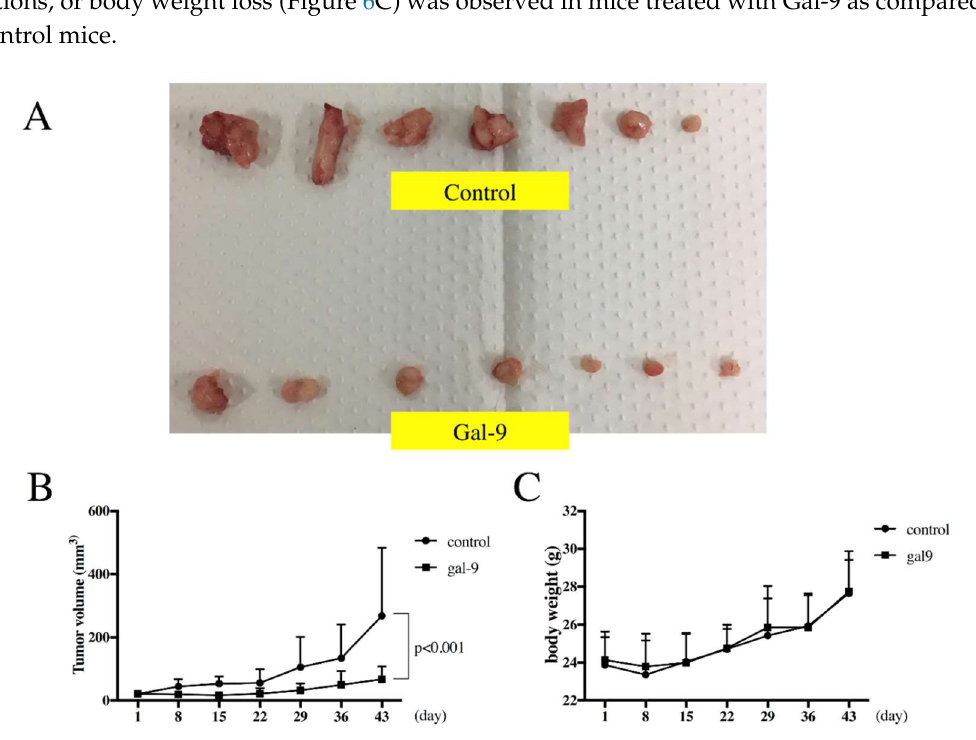
Figure 6. Gal-9 inhibits the growth of ESCC cells in the xenograft mouse model. ( A ) Image of tumors excised from Gal-9–treated and control (only PBS) mice; ( B ) Mean tumor volume of Gal-9 treated mice and control mice. KYSE-150 cells (5 × 10 6 cells / animal) were subcutaneously injected into the flank of each mouse. Gal-9 was administered on day 5 after the tumor mass was formed. The horizontal axis shows the days of the administration of Gal-9. Tumor growth was significantly suppressed in the Gal-9 treated mice when compared to control mice; ( C ) Changes in the body weight in control and Gal-9–treated mice. No di ff erence was observed in both groups during the experimental period. The error bars represent the standard deviation (SD).